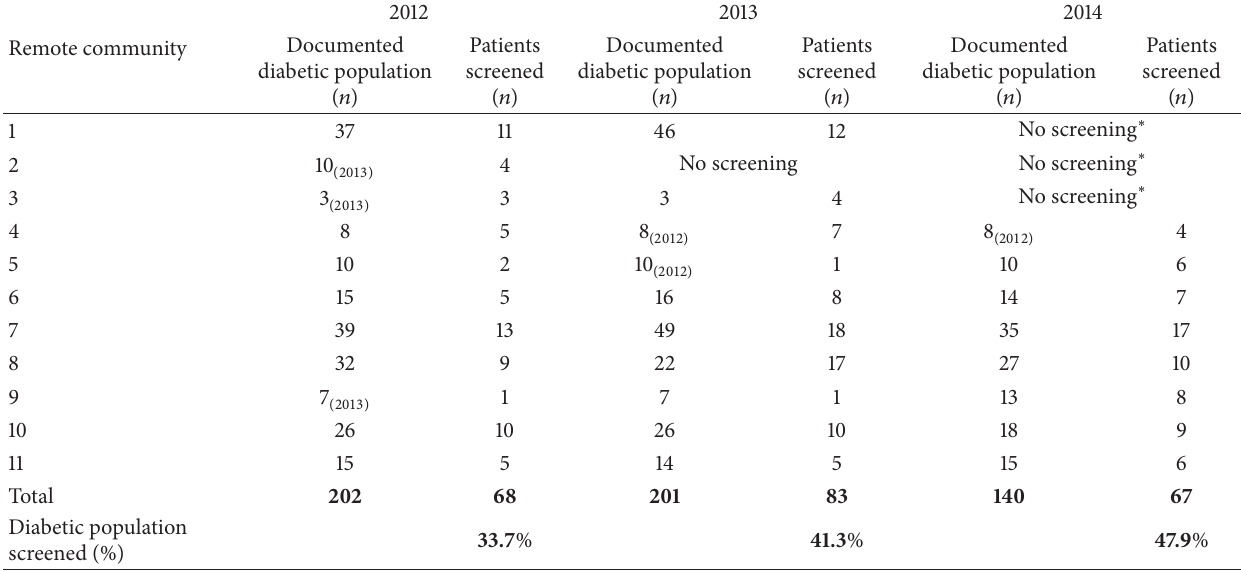
Table 1: The documented diabetic population in remote communities visited by the screening program.